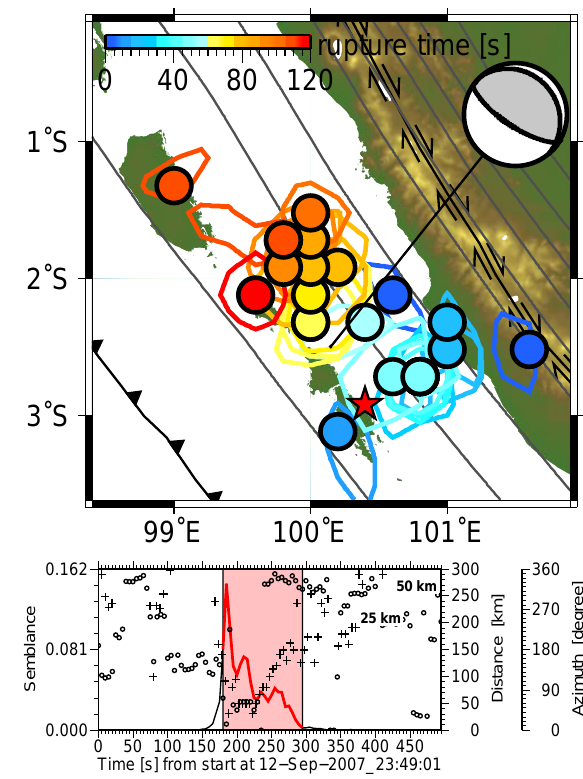
Fig. 3. Results for the M 8 . 0 Sumatra earthquake on 12 September 2007, 11:10. Top: epicentral area with maxima (dots) and 0.9 con- tour lines of normalised semblance source maps. Colours indicate rupture time. Star: epicentre (GEOFON). The focal mechanism shows the centroid moment tensor solution (Ekstr¨om and Nettles, 2009). Grey contour lines indicate slab depth (Gudmundsson and Sambridge, 1998). Bottom: time series of maximum of semblance maxima over all grid points (black/red line), distance (crosses) from and azimuth (circles) to epicentre from multiplied semblance source maps. Origin time (GEOFON) is a 200s. Values at times outside the interval marked in red are attributed to noise and phases foll- wing the P waves. The red line and area: time interval when sta/lta trigger indicates rupturing.